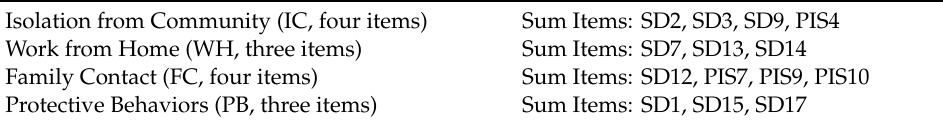
Table 4. Scoring Instructions for the Social Distance Scale (v.1).